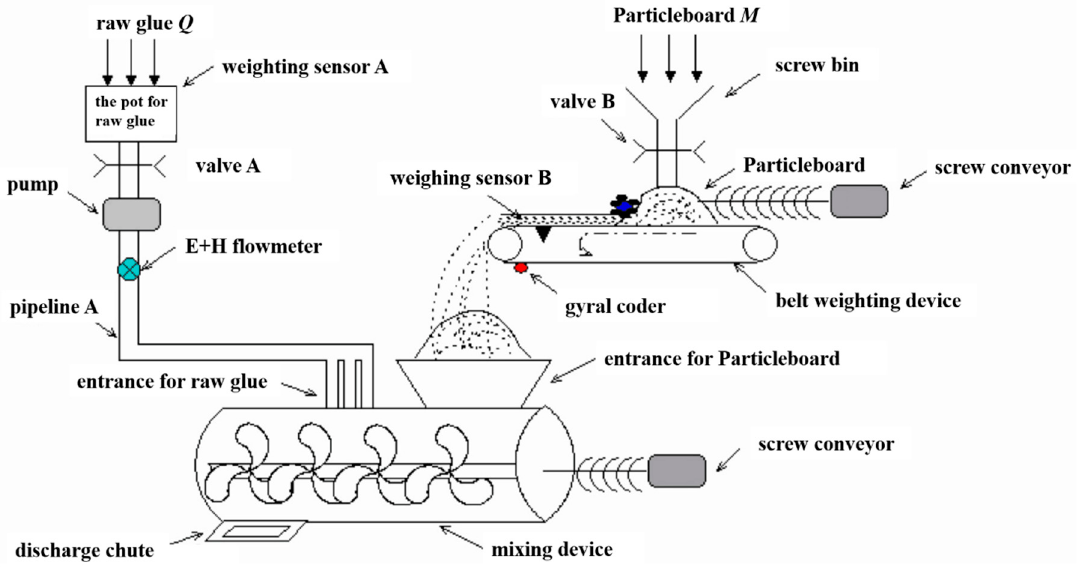
Figure 1. Particleboard glue mixing and dosing system.